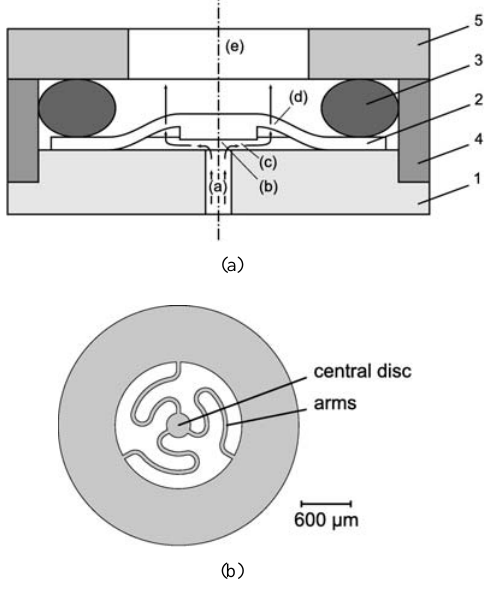
Fig. 1: Valve presentation (a) valve structure (scale is not respected); (b) spider-spring